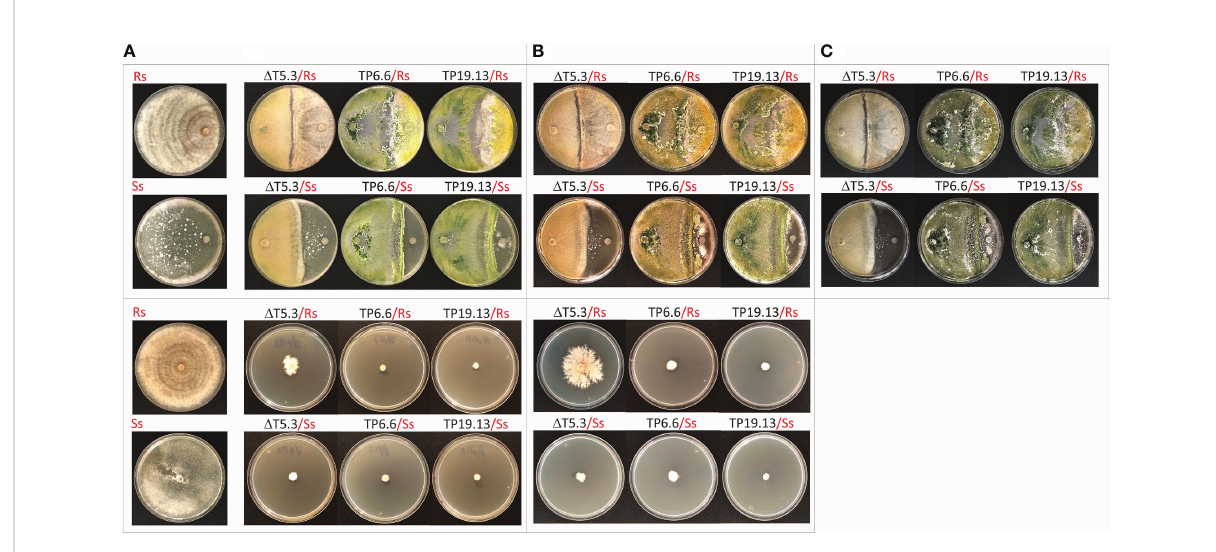
FIGURE 4 Upper panels. Direct confrontation assays of Trichoderma strains, D tri5.3 (= D T5.3), TP6.6 and TP19.13, versus the pathogens R. solani R43 (Rs) ( fi rst row), or S. sclerotiorum S47 (Ss) (second row). Plates were incubated for one (A) , two (B) , or three weeks (C) . Control plates with the pathogens without Trichoderma are included in the left column. In all confrontations pathogen´s plugs are located at the right and Trichoderma plugs are located at the left of the plates. Lower panels. Cellophane membrane assays to analyze the antifungal activity of the same Trichoderma strains indicated above against Rs (third row) and Ss (forth row). Plates were incubated for one (A) or two (B) weeks after placement of the pathogen plug. Control plates with the pathogens grown without Trichoderma metabolites are included at the left column.